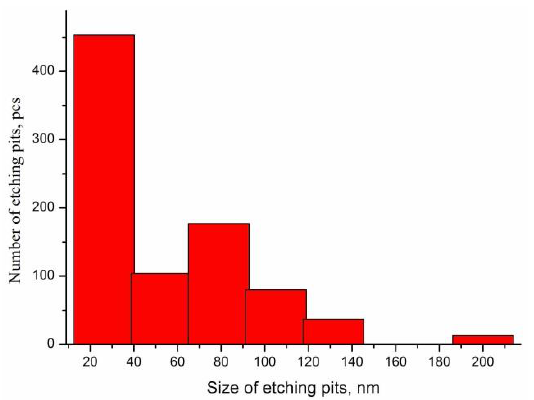
Figure 2. The distribution of the pits by their size for Figure 1d.